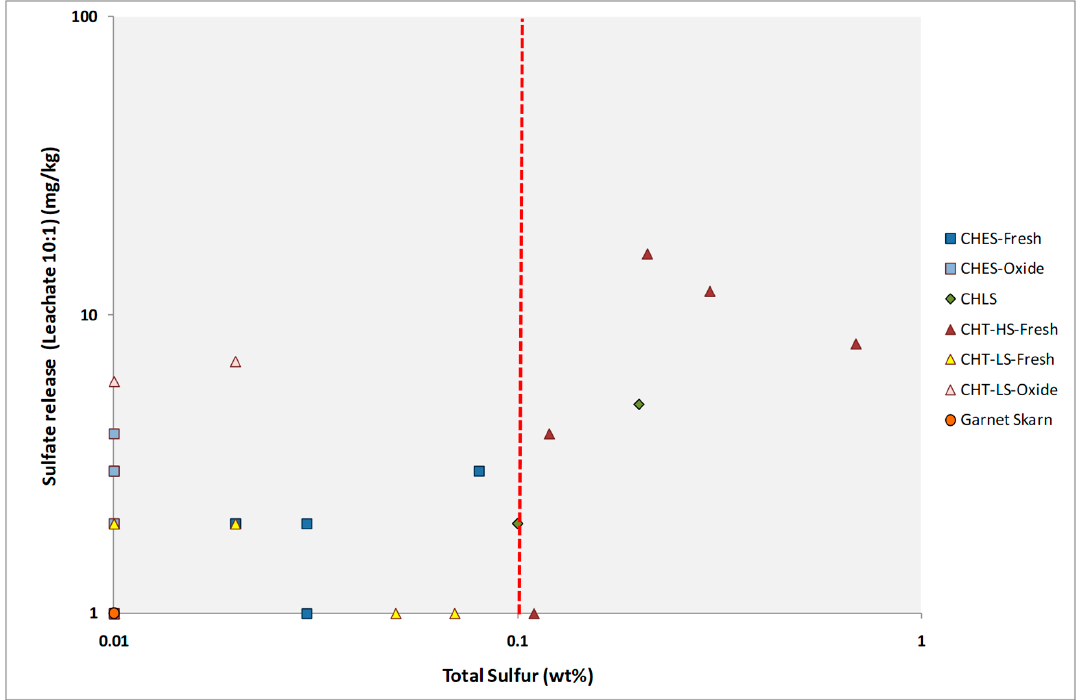
Figure 10. Scatter plot of Total sulfur vs. Sulfate sulfur release for the deionised water leach tests. For arsenic and iron the results show they can be leached from one or more material types at relatively high concentrations with an apparent inverse relationship to each other but not to pH (Figure 11).